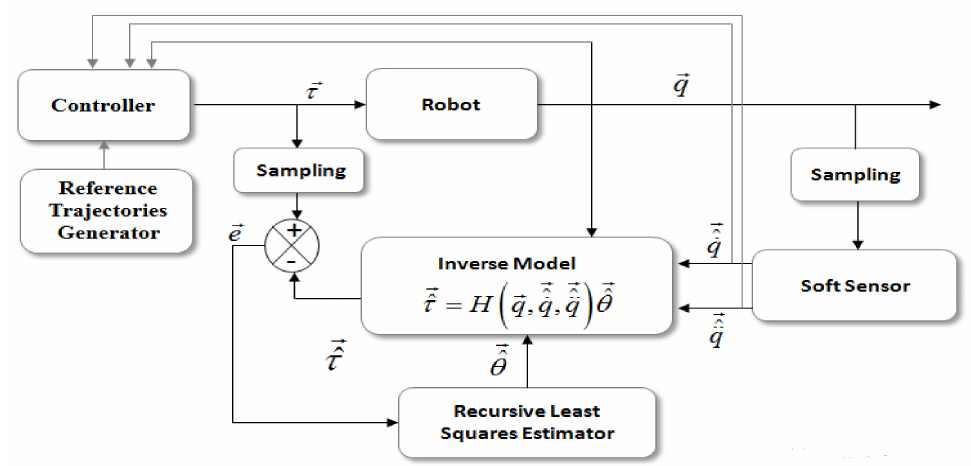
Figure 1. The general principle of the closed-loop identification